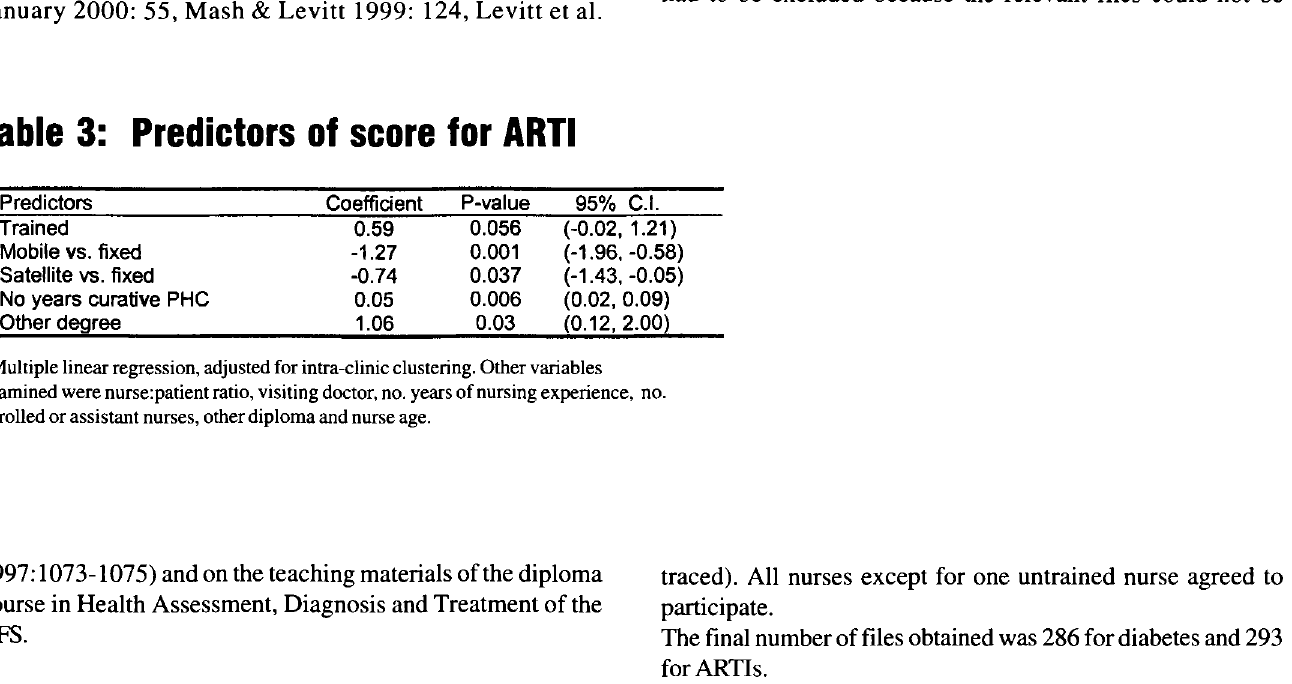
Predictors of score for